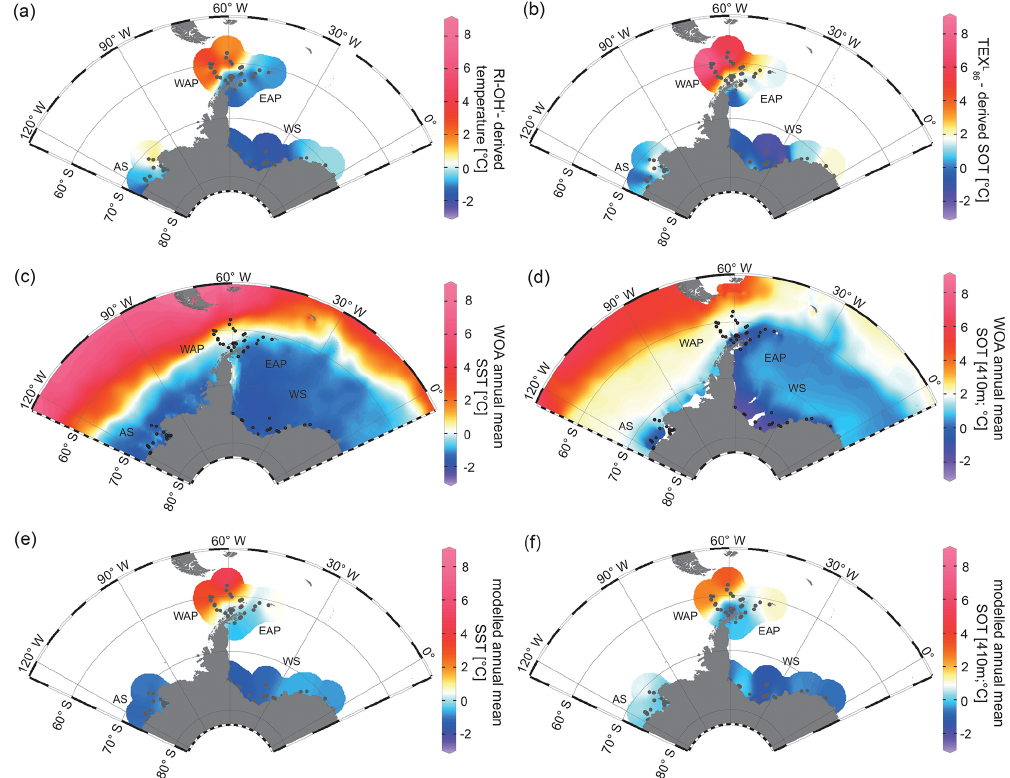
-derived SOT, (c) WOA13 SST (Locarnini 86